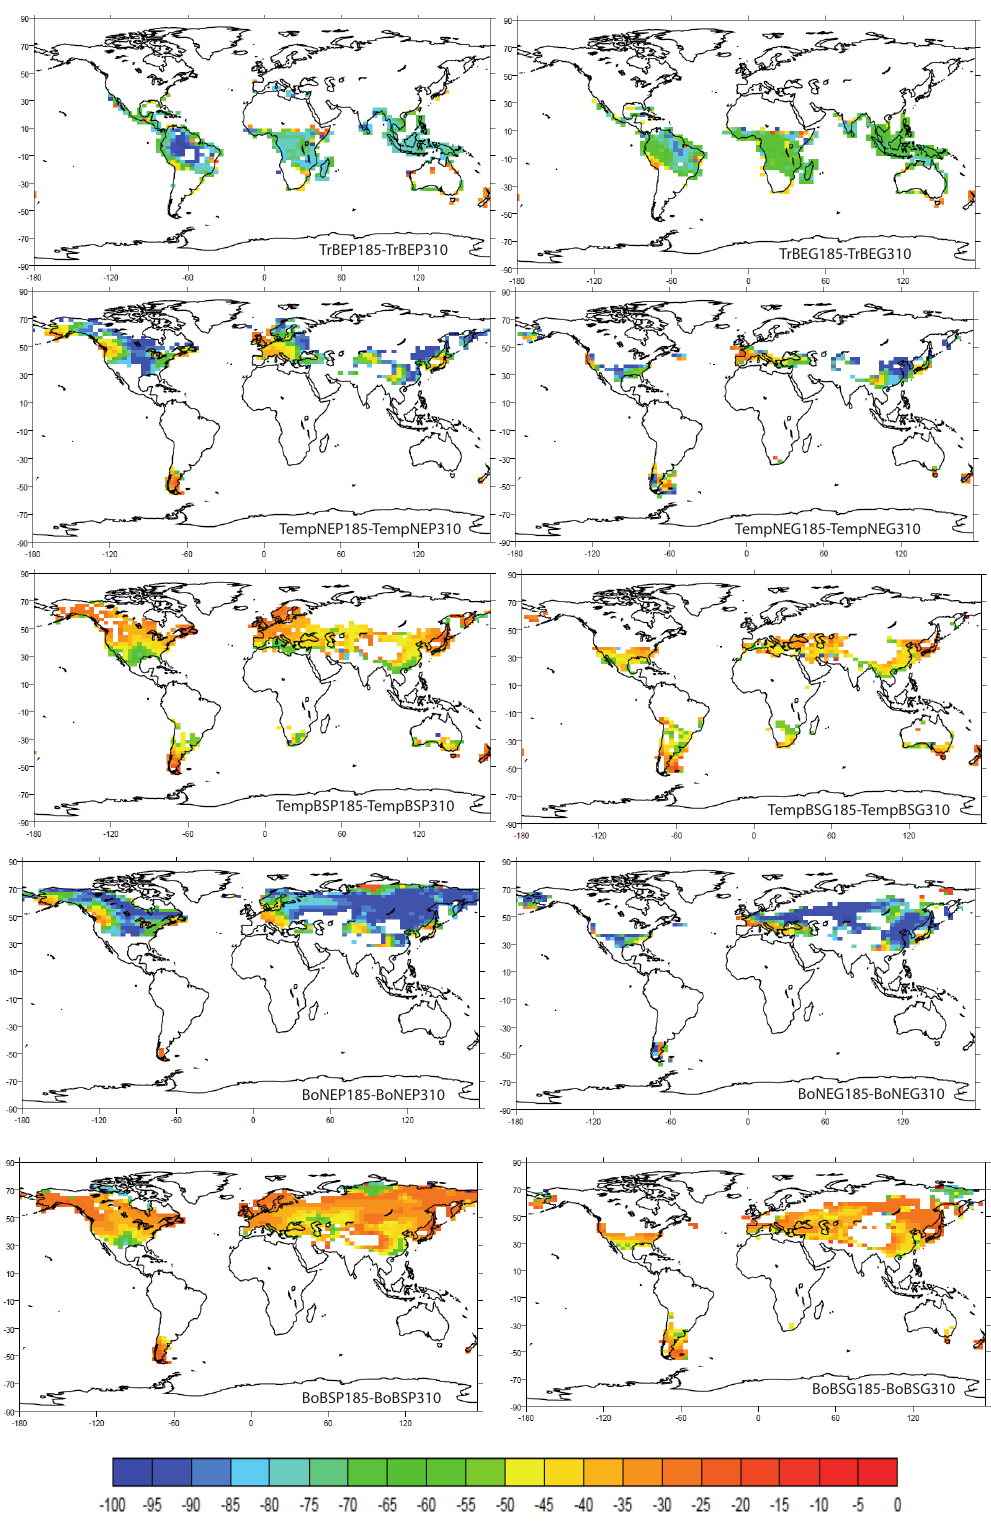
Fig. 15. Changes in annual NPP (in %) in the fixed vegetation runs when CO 2 is decreased from 310 to 185ppm with a CTRL (left column) or LGM (right column) climate in background. Names of the simulations: see Table